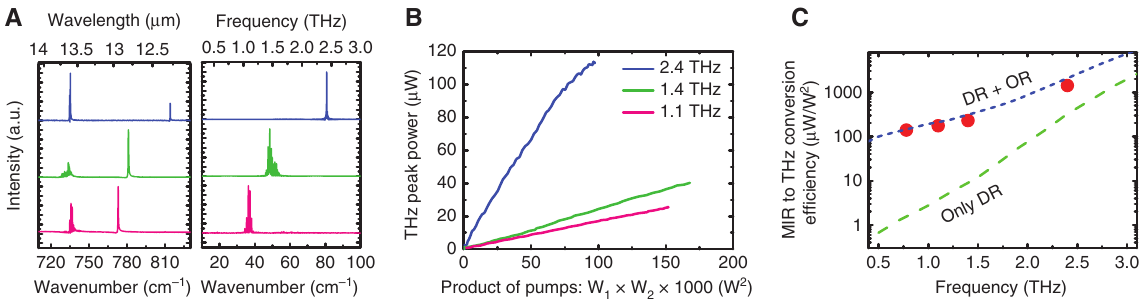
Figure 4: Room-temperature performance of 1.1-THz (red line), 1.4-THz (green line), and 2.4-THz (blue line) sources. (A) MIR and THz spectra. (B) THz peak power output vs. the product of MIR pump powers. (C) The experiment and simulation results of the MIR-to-THz conversion